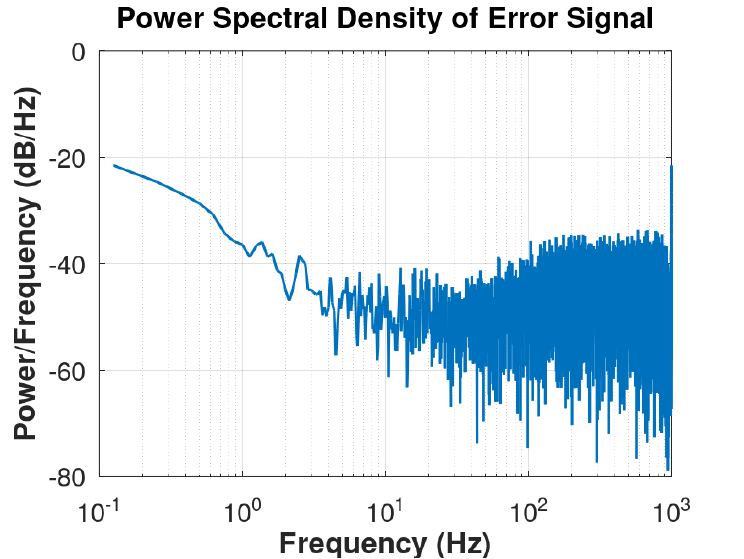
Figure 7. Behavior of the power spectral density (PSD) of the error signal by